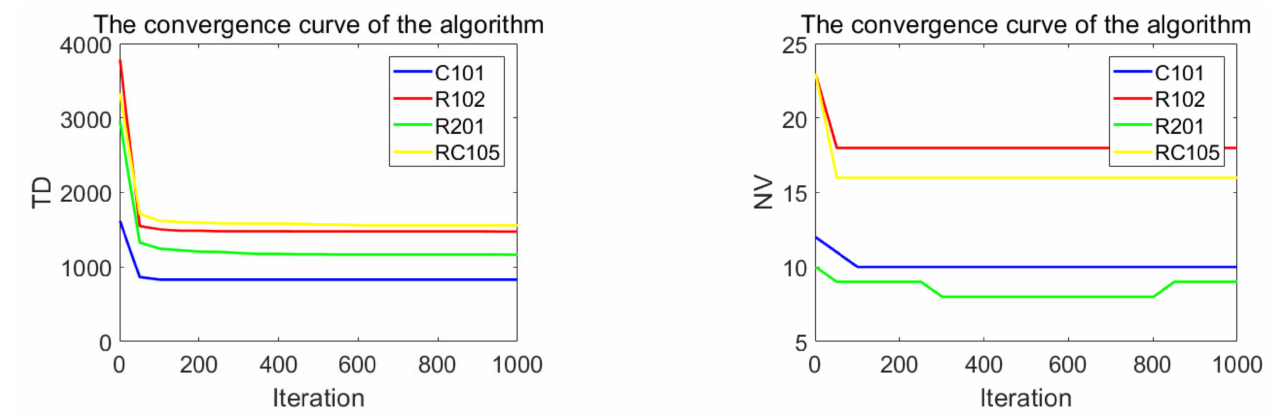
Figure 8. The convergence curve after 1000 iterations of the algorithm.